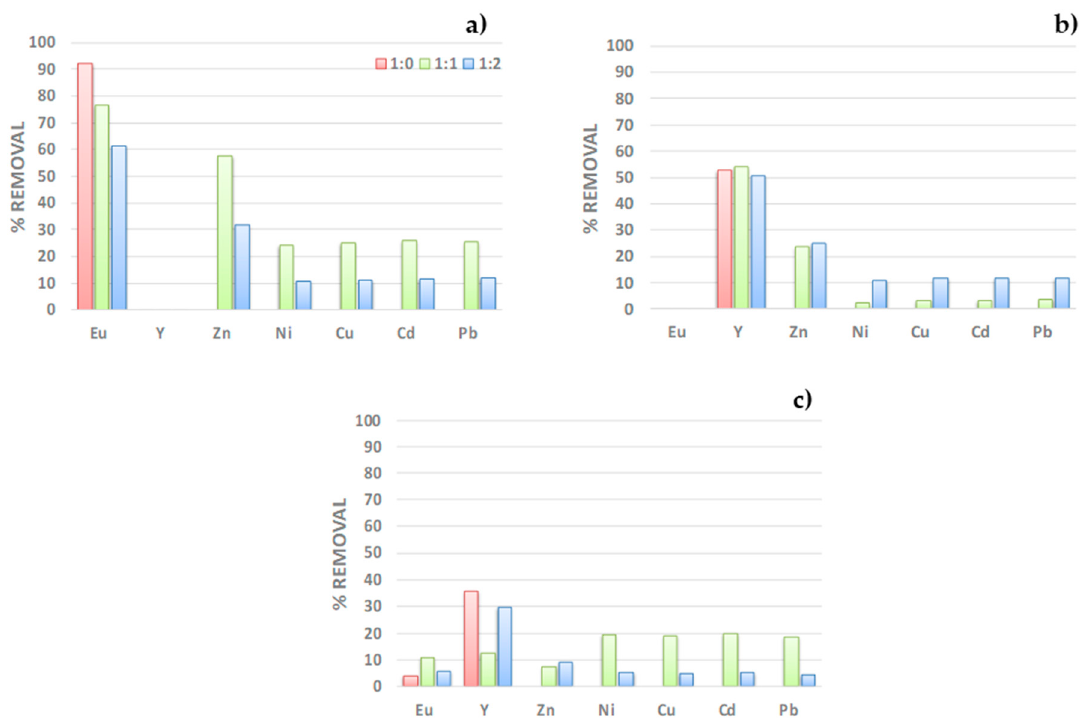
Figure 8. Removal percentage of ( a ) Eu(III), ( b ) Y(III), and ( c ) Eu(III)/Y(III) mixture in the presence of different interfering cations.